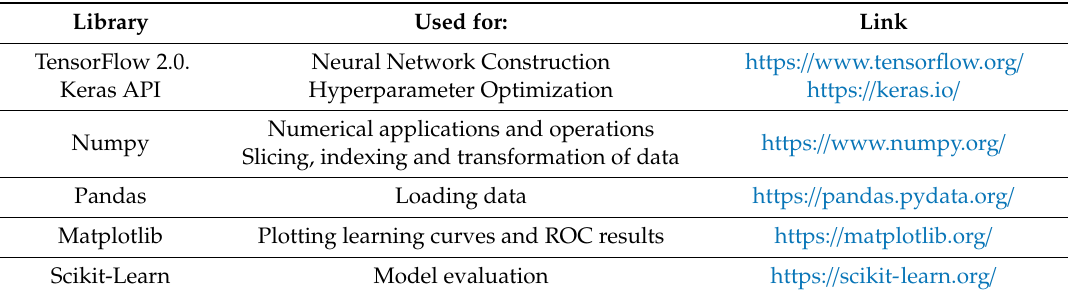
Table A2. Table presenting the Python libraries used for Deep Learning applications. Library Used for: TensorFlow